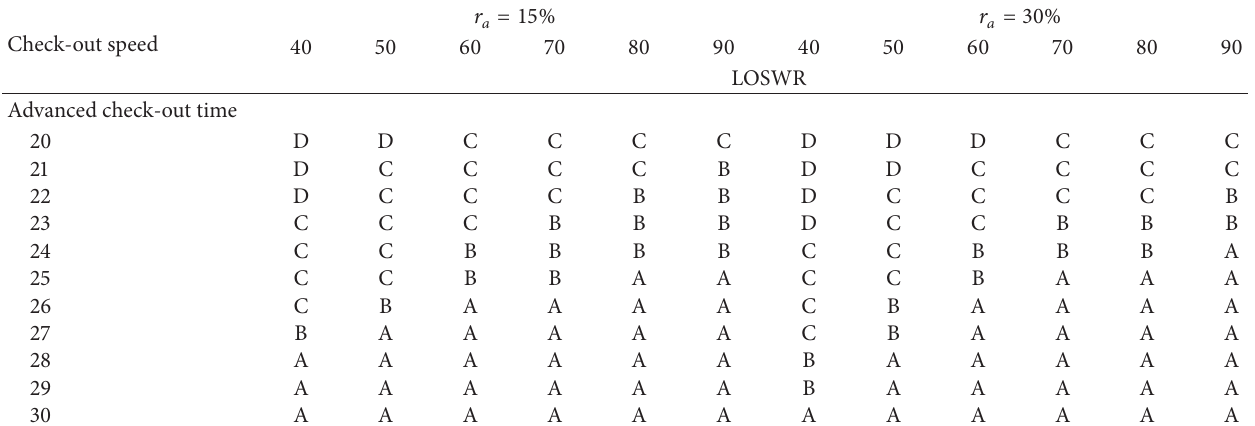
Table 11: The LOSWR varies over the values of 𝑡 𝑐 and V 𝑐 ( 𝑟 𝑎 ).